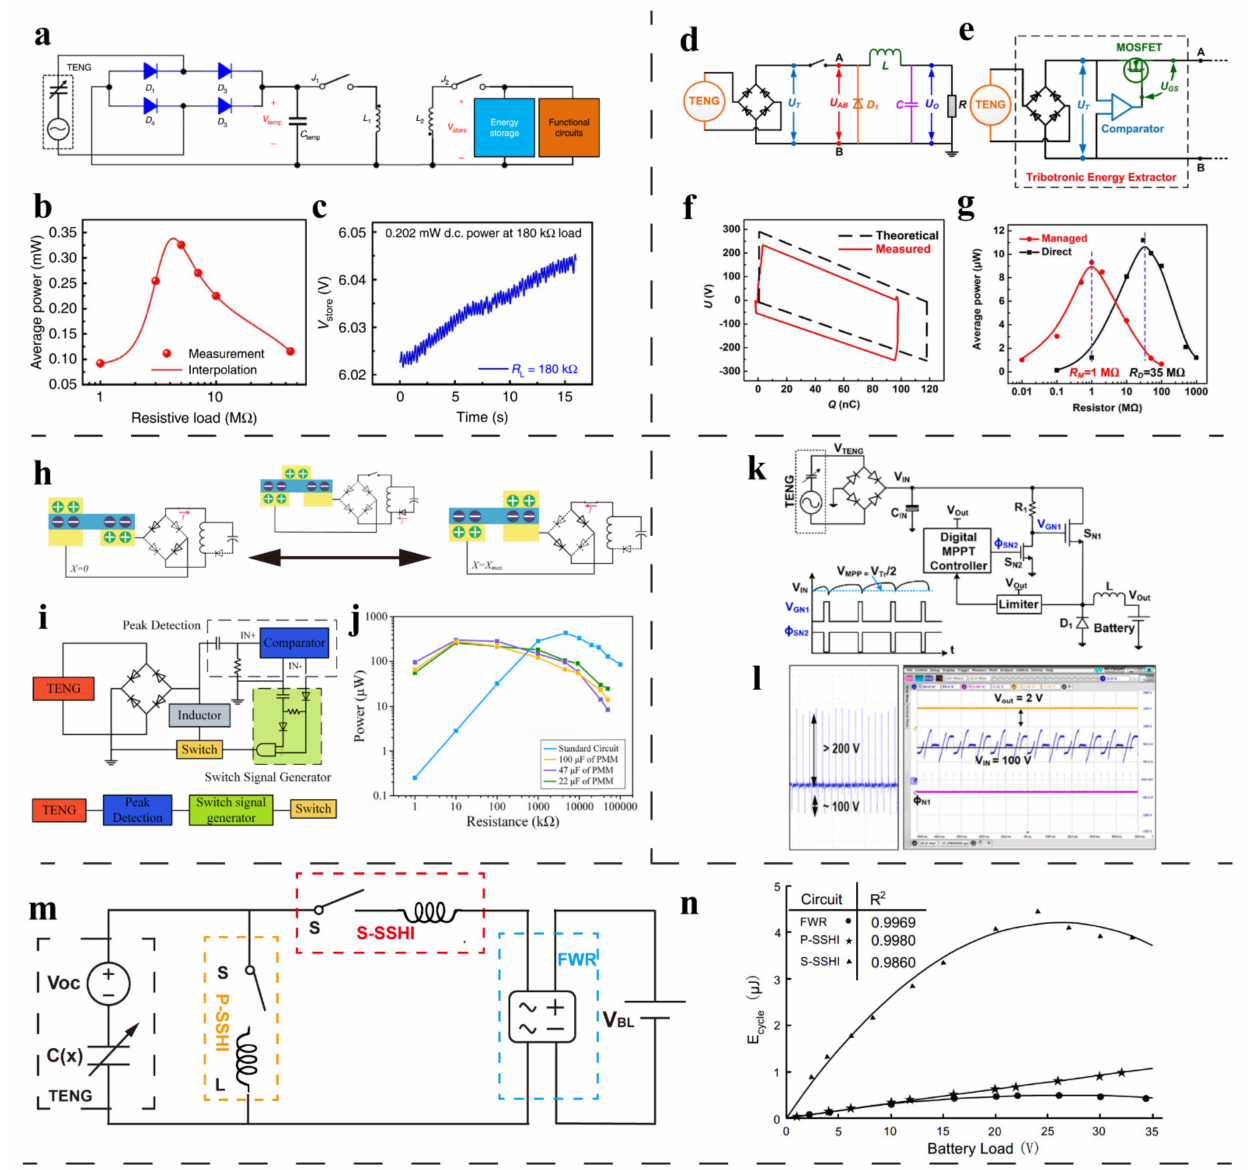
Figure 9. Power management with MOSFET switch. ( a ) The two-stage energy releasing power management circuit. ( b ) Relationship between average power and resistance before